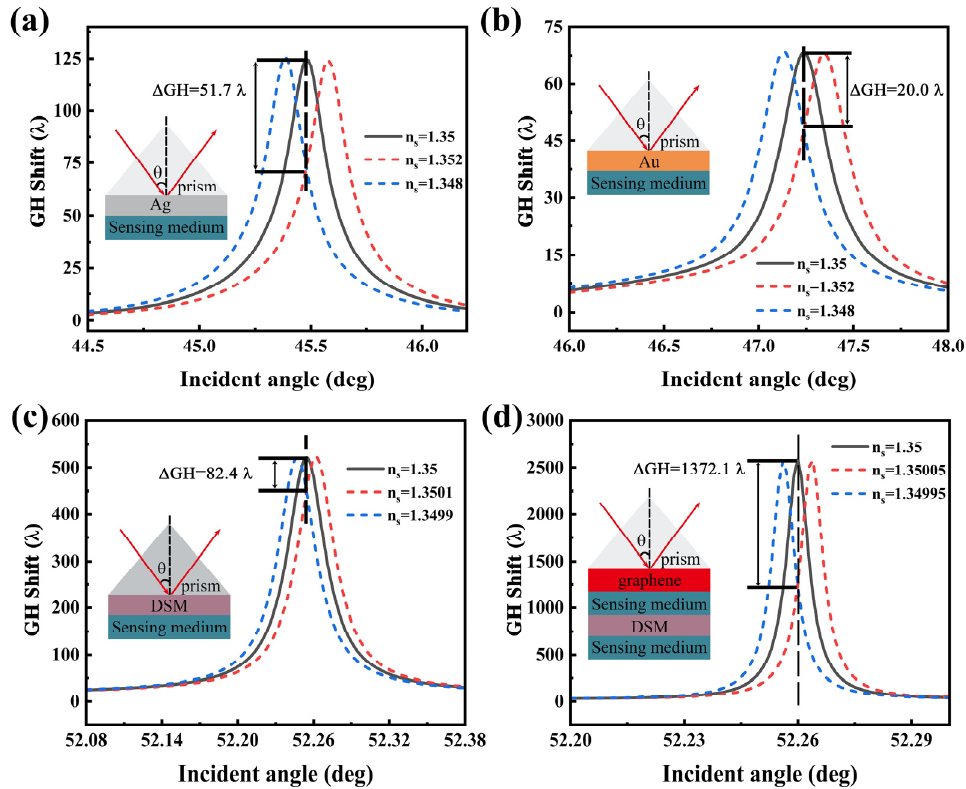
Figure 9. Dependence of the GH shifts with incident angle in a small refractive index range in ( a , b ) traditional metal Ag (Au) SPR structure (45 nm), ( c ) DSM based SPR structure (380 nm), and ( d ) DSM-based coupling structure.